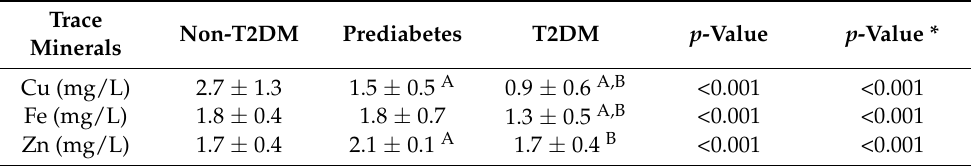
Table 2. Differences in Serum Cu, Fe and Zn according to T2DM status. Trace Minerals